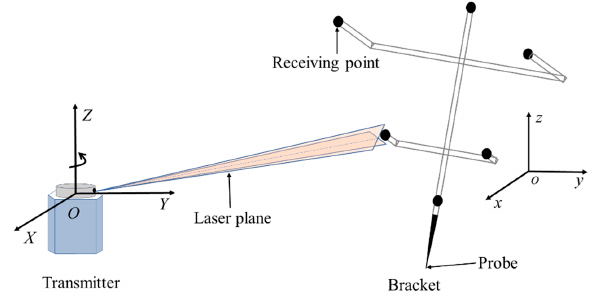
Figure 4. Schematic illustrating the photoelectric scanning multi-angle resection positioning method using an external receiver array. The receiver array includes a fixed number of photoelectric receivers mounted within a known array coordinate system o-xyz with its origin (i.e., the probe point) located at a known measurement point within the transmitter station coordinate system O-XYZ . These receivers serve as control points in the o-xyz frame with corresponding points in the O-XYZ frame obtained by laser